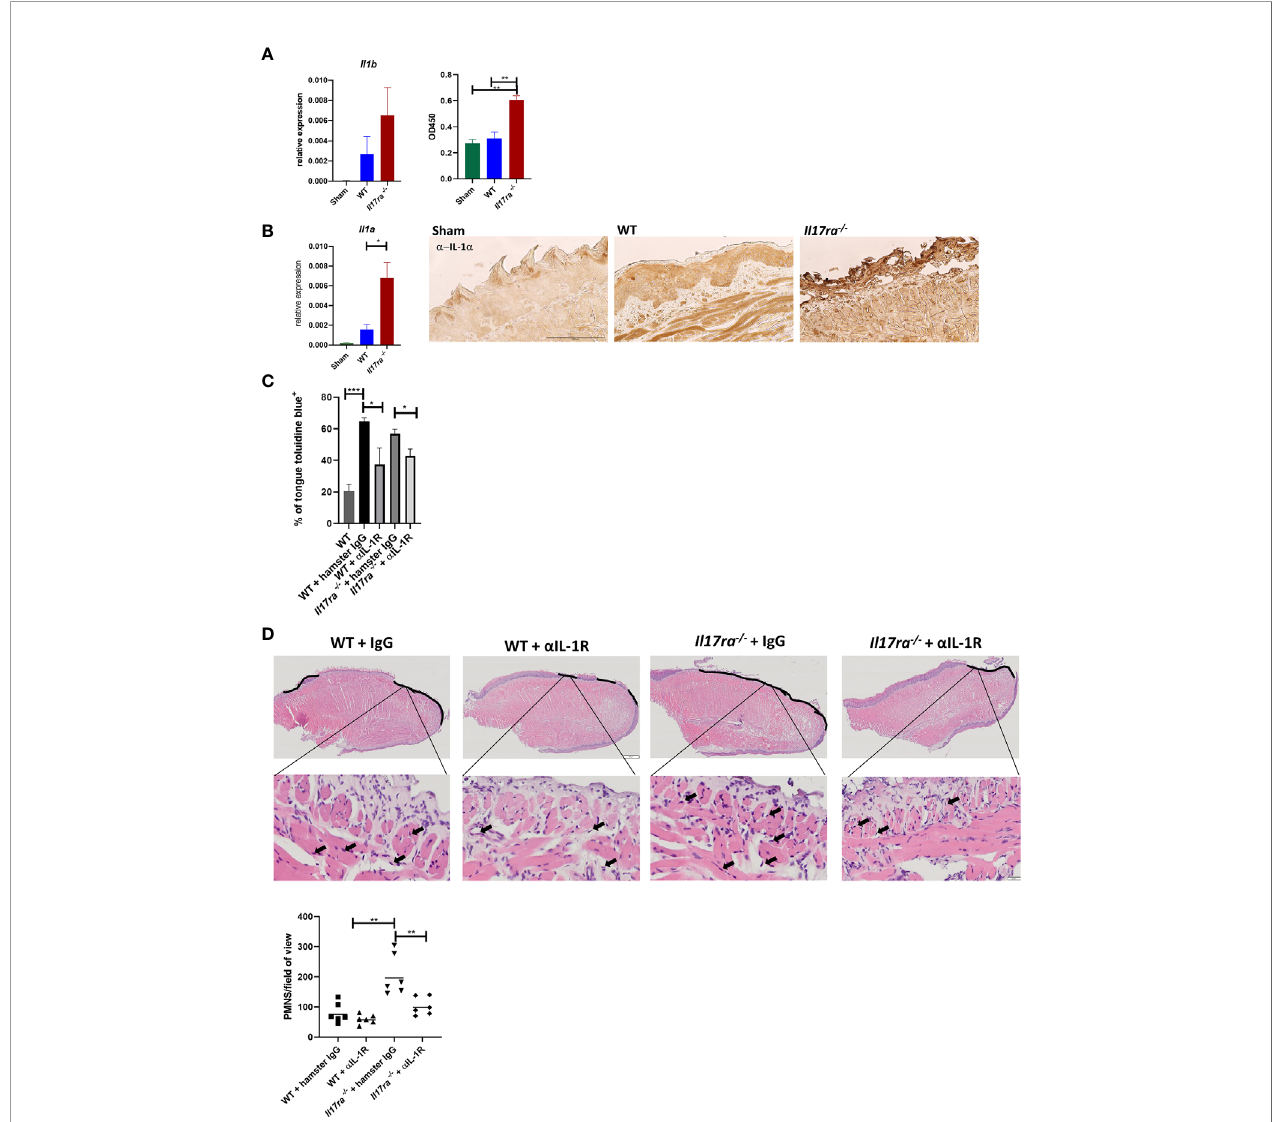
FIGURE 6 | Neutralization of IL-1R alleviates damage in the absence of IL-17RA. (A) Gene expression and circulating levels of IL-1 b both analyzed by ANOVA with Tukey ’ s. For gene expression data pooled from at least three experiments. Protein expression represents one experiment. (B) Gene expression and IHC of IL-1 a pooled from at least three independent experiments. Scale bar, 100 m M. Analyzed by ANOVA with Tukey ’ s. (C) Mice were treated i.p. with a IL-1R at 300 µg on days 0, 2, 4, 6, and 8 (n = at least four). Control animals received appropriate isotype controls ( Supplementary Table 2 ). Data represents one experiment. Tongues were harvested and damage quanti fi ed by toluidine blue+ staining on D11. Quanti fi cation of damage analyzed by ANOVA with Tukey ’ s post hoc . (D) Staining by hematoxylin and eosin of sectioned tongues and quanti fi cation of neutrophils on day 11 following HNI in the ulcer boundary area. Images captured at 100 m M and zoomed in at 50 m M. Data analyzed by ANOVA with Tukey ’ s post hoc . Data shown as means ± SEM, (*P < 0.05, **P < 0.01, ***P <